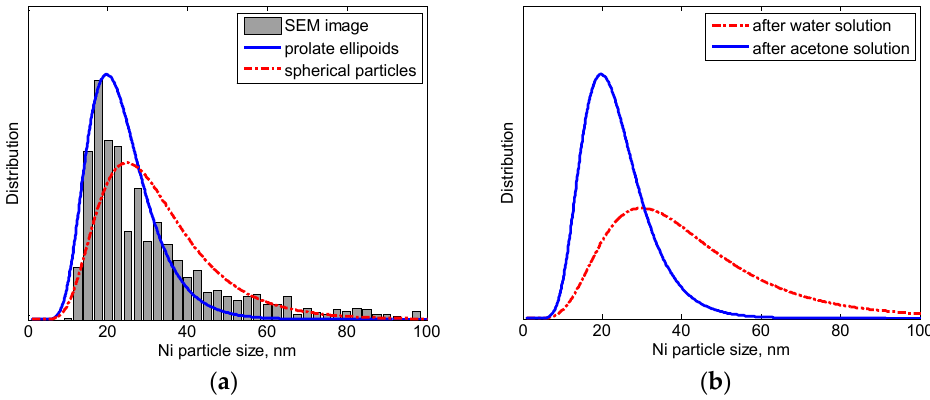
Figure 10. ( a ) Comparison of particle size distributions obtained with XRD (continuous lines) or with SEM (histogram), assuming a log normal distribution of spherical (red) or prolate ellipsoidal (blue) Ni particles. The long axis ( r 3 ) of the prolate ellipsoids is parallel to the surface normal of the carbon fibers; ( b ) XRD particle size distributions for acetone and water-based Ni particles of prolate ellipsoidal shape.